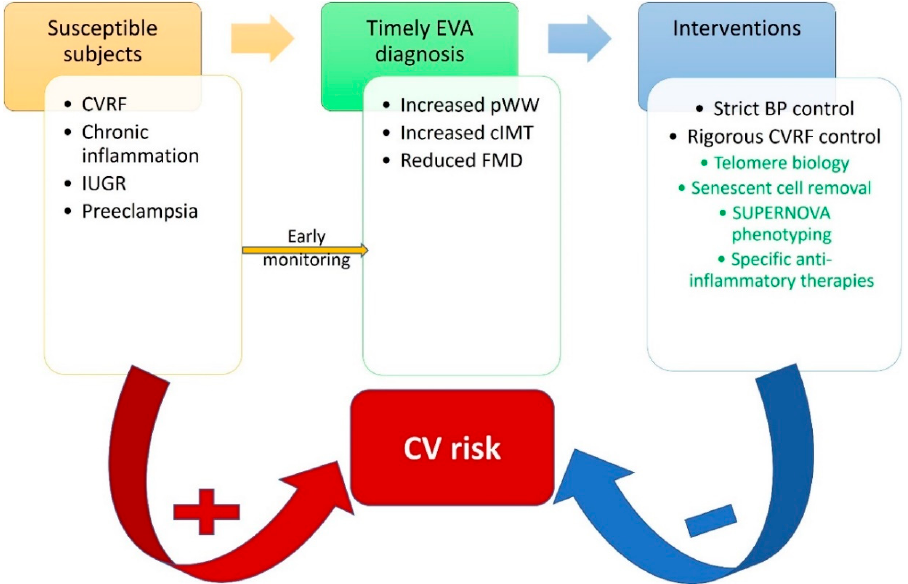
Figure 5. Proposed cardiovascular risk reduction strategy through identification of susceptible individuals, early diagnostic protocols and timely interventions. BP—blood pressure; cIMT—carotid intima-media thickness; CVRF—cardiovascular risk factors; FMD—flow-mediated dilation; IUGR—intrauterine growth restriction; pWW—pulse wave velocity. In green, promising future in ‐